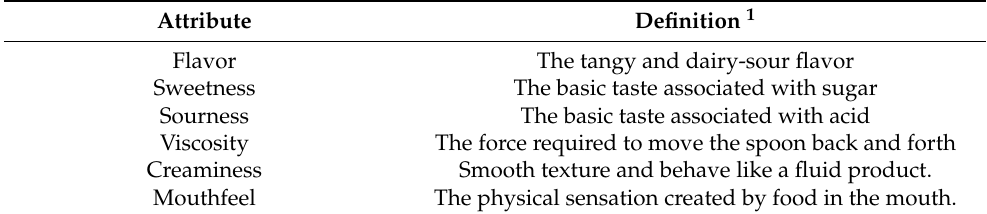
Table 1. Sensory attributes of Greek yogurt. Attribute Definition 1 Flavor The tangy and dairy-sour flavor Sweetness The basic taste associated with sugar Sourness The basic taste associated with acid Viscosity The force required to move the spoon back and forth Creaminess Smooth texture and behave like a fluid product. Mouthfeel The physical sensation created by food in the